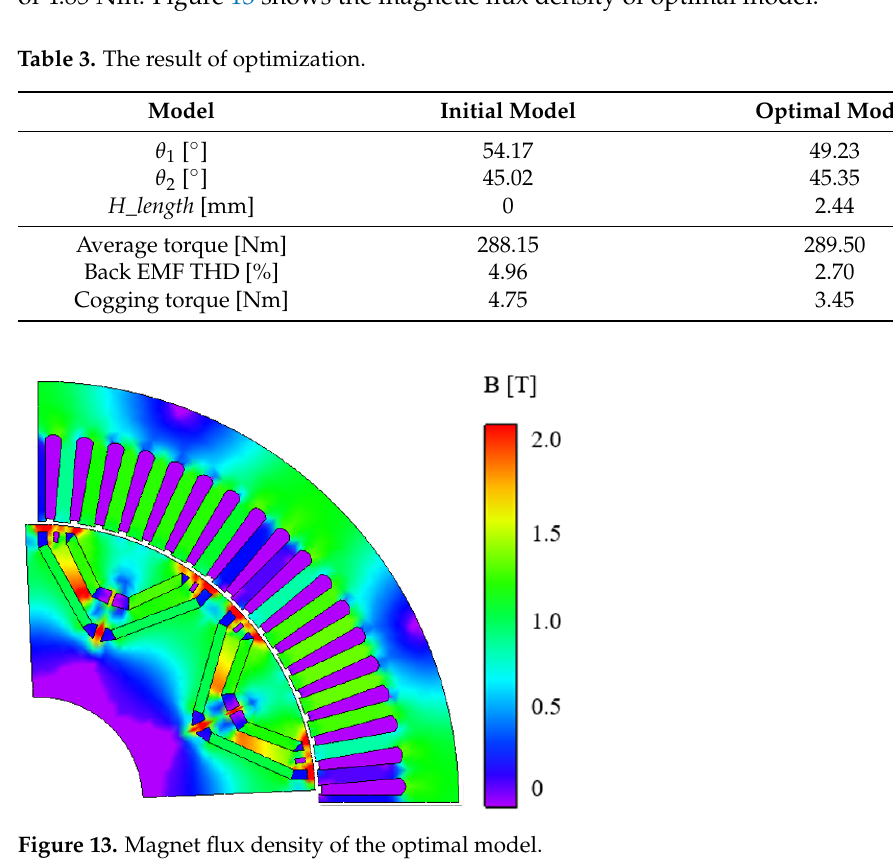
Figure 12. C omparison of initial model and optimal model. ( a ) Torque; ( b ) Back EMF; ( c ) Cogging torque.